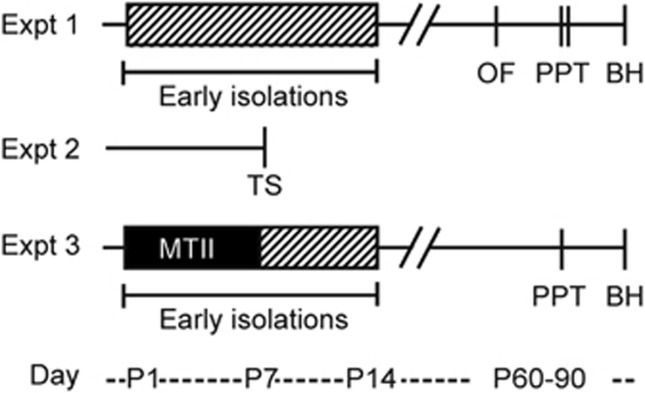
Experimental design. In Experiment (Expt) 1, entire litters were isolated from both parents and siblings in a temperature-controlled incubator for 3 h per day from PND1–14, with PND0 as the day of birth. Control litters were left undisturbed, apart from being weighed every 3 days. Anxiety-like behavior was tested in the open field (OF), social attachment in the partner preference test (PPT) after 24 and 48 h of cohabitation, and brains were harvested (BH) to perform autoradiography for OTR. Brains from a subset of females who were naive to behavioral testing also underwent autoradiography. In Expt 2, the impact of a 5min body and anogenital paint-brush tactile stimulation (TS) on hypothalamic oxytocin (OT) and vasopressin (AVP) neuronal activation was tested in PND6–7 pups. For 1 h before and after stimulation, pups were kept in a temperature-controlled incubator. In Expt 3, pups were isolated as in Expt 1, but given melanotan-II (MTII) or saline daily for the first week of life. OTR, oxytocin receptor; PND, postnatal day.